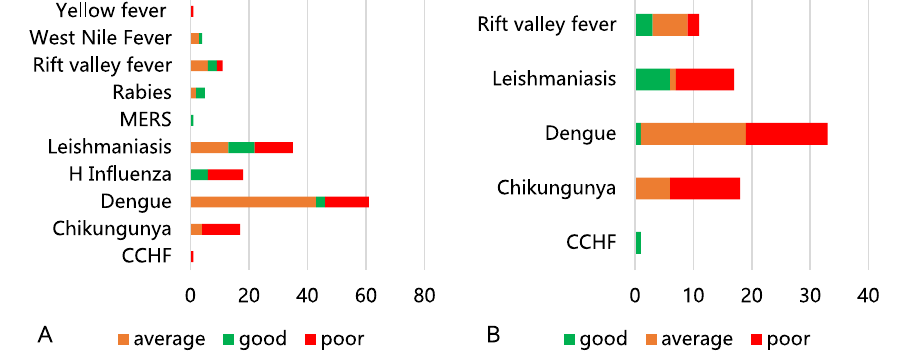
Fig. 3 Vector-borne and zoonotic diseases in the Eastern Mediter- ranean region—percentage of studies reporting varying levels of: A overall disease control measures, and B animal source/vector control measures. Note: the percentage of studies is calculated out of number